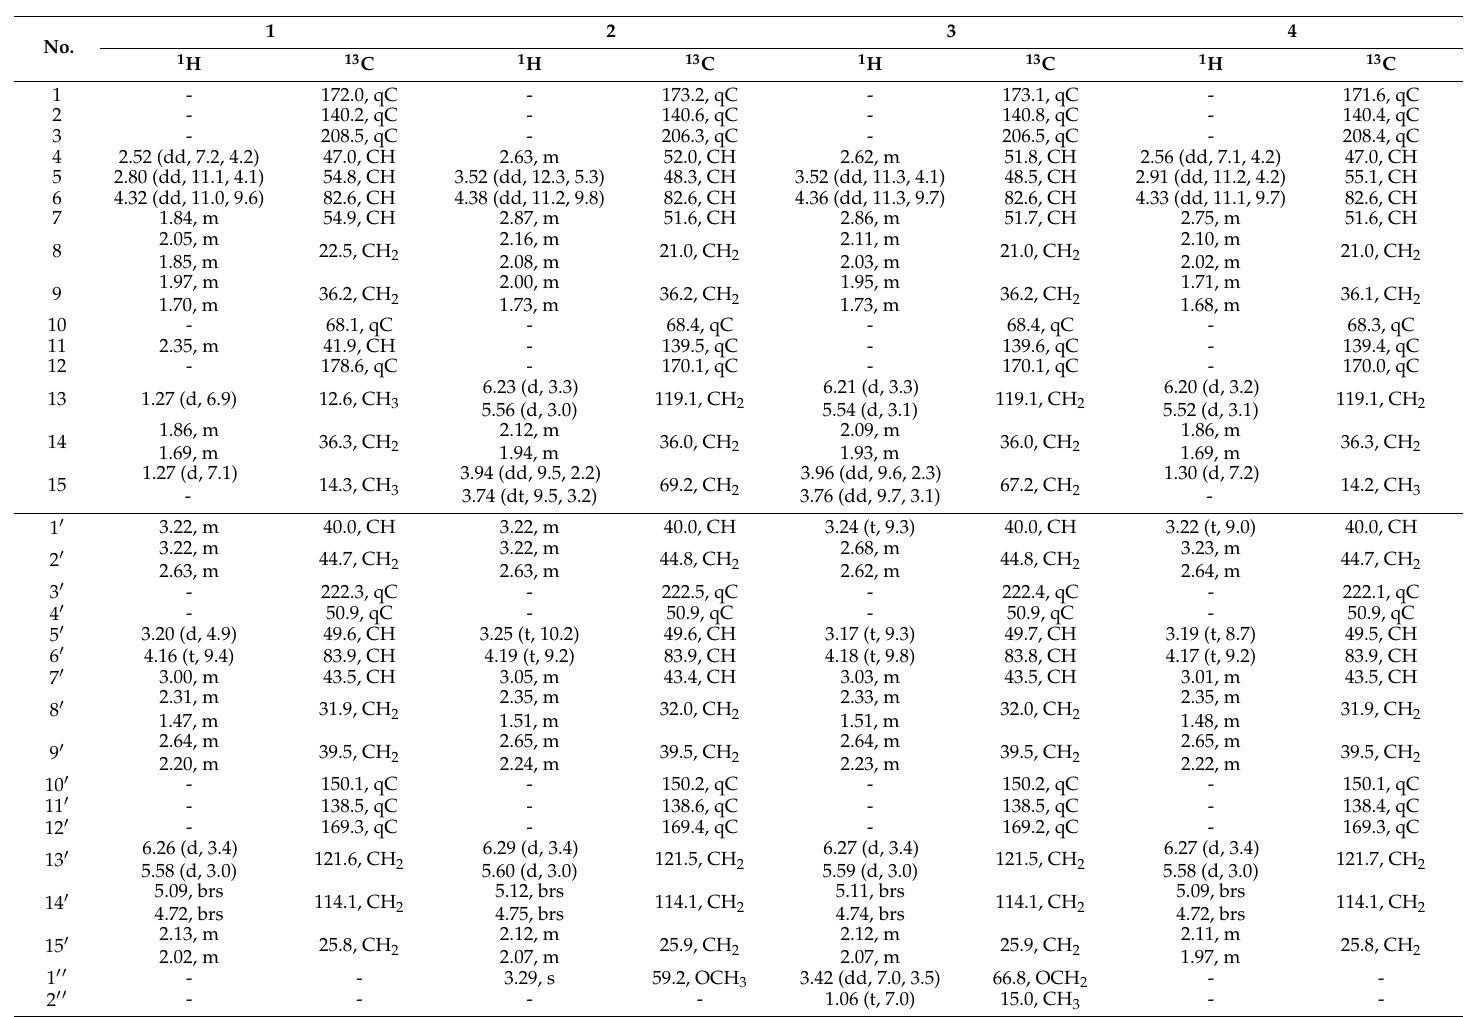
Table 1. 1 H- (600 MHz) and 13 C- (150 MHz) NMR spectroscopic data of Compounds 1 – 4 a